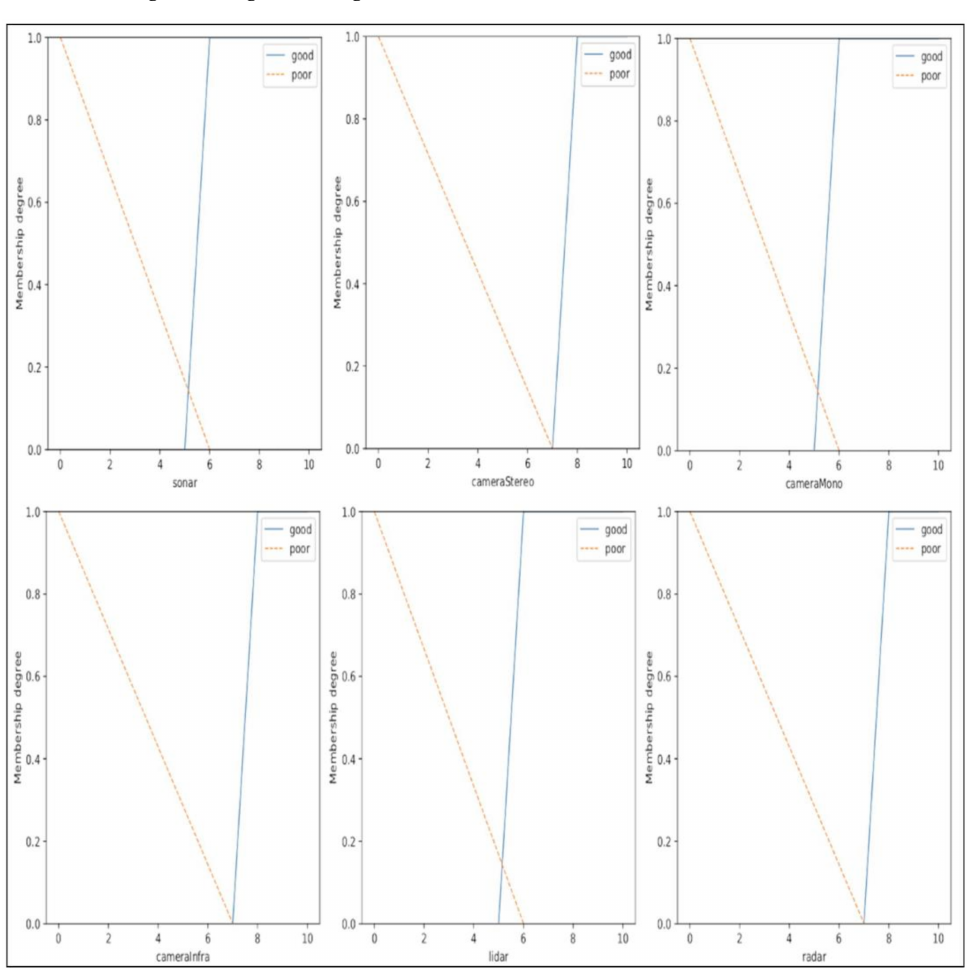
Figure 10. The fuzzy representation of